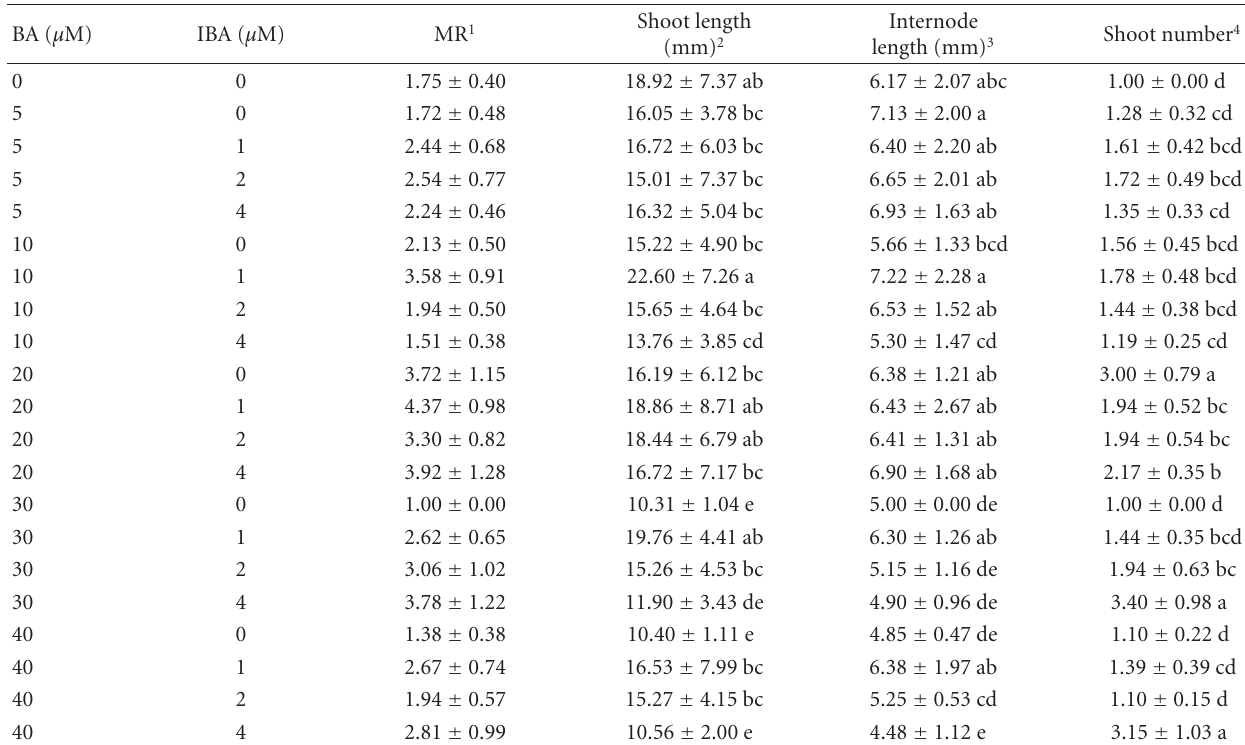
Table 3: E ff ect of benzylaminopurine (BA) and indole butyric acid (IBA) concentrations on in vitro shoot multiplication of Handroanthus impetiginosus on WPM basic medium after 30-day